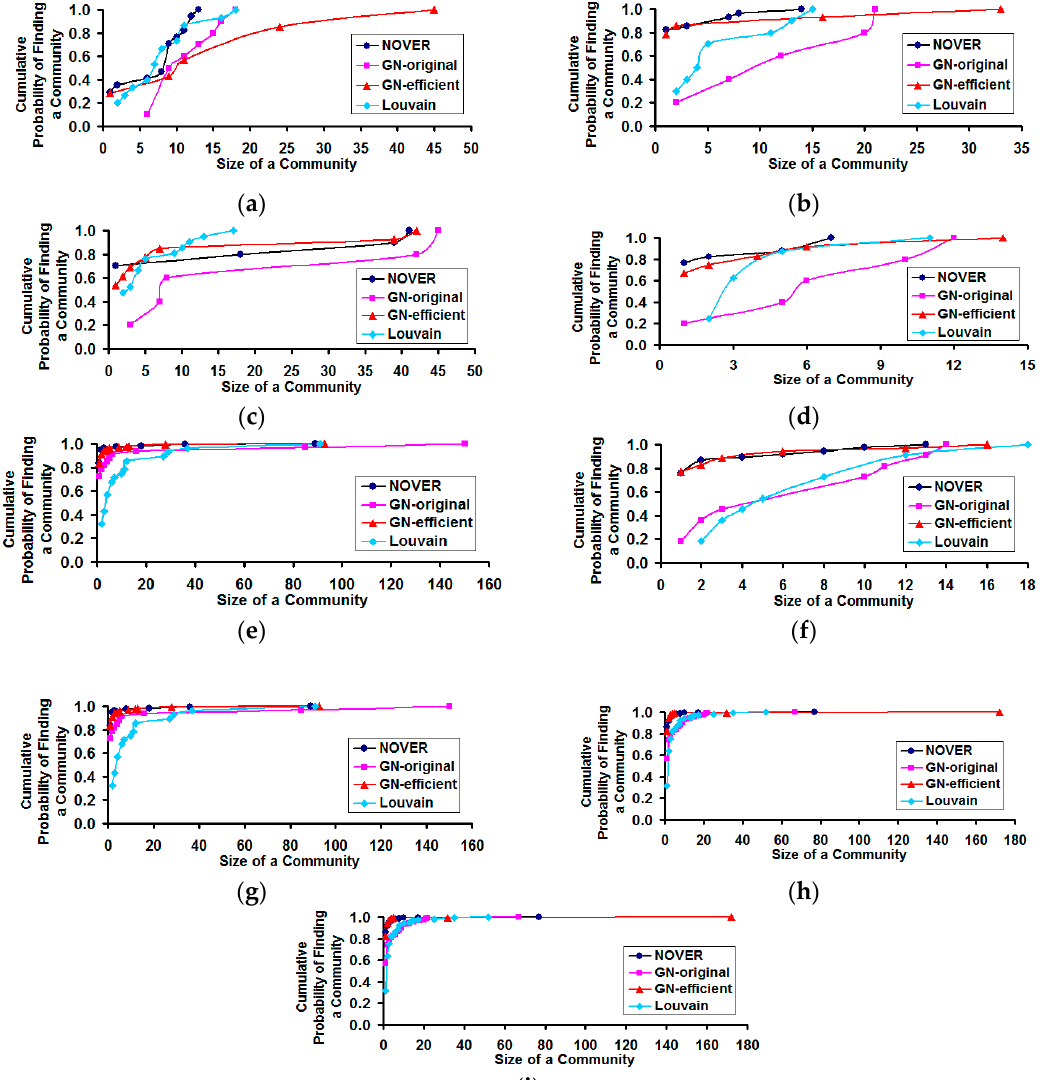
Figure 10. Cumulative modularity score vs. fraction of the communities of the smallest size for the community detection algorithms on real-world Network graphs. ( a ) US Football Network (FN); ( b ) Dolphin Network (DN); ( c ) US Politics Book Network (PN); ( d ) Karate Network (KN); ( e ) C. Elegans Network (NN); ( f ) Les Miserables Network (LN); ( g ) Citation GD Network (CN); ( h ) Erdos971 Collaboration Network (EN); ( i ) US Airports Network (AN).